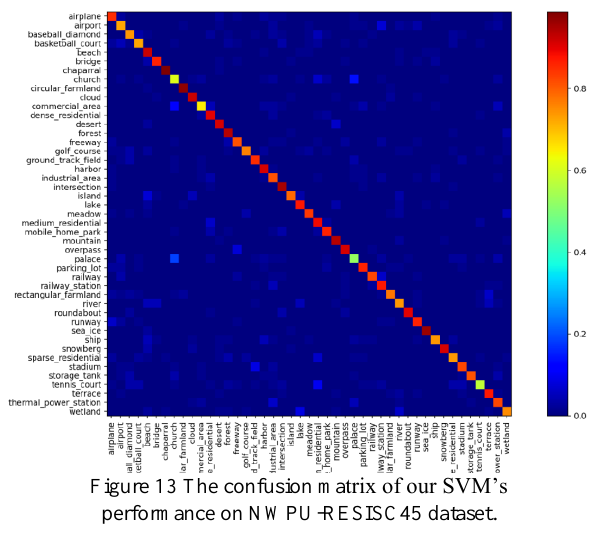
Figure 13 The confusion matrix of our SVM’s performance on NWPU-RESISC45